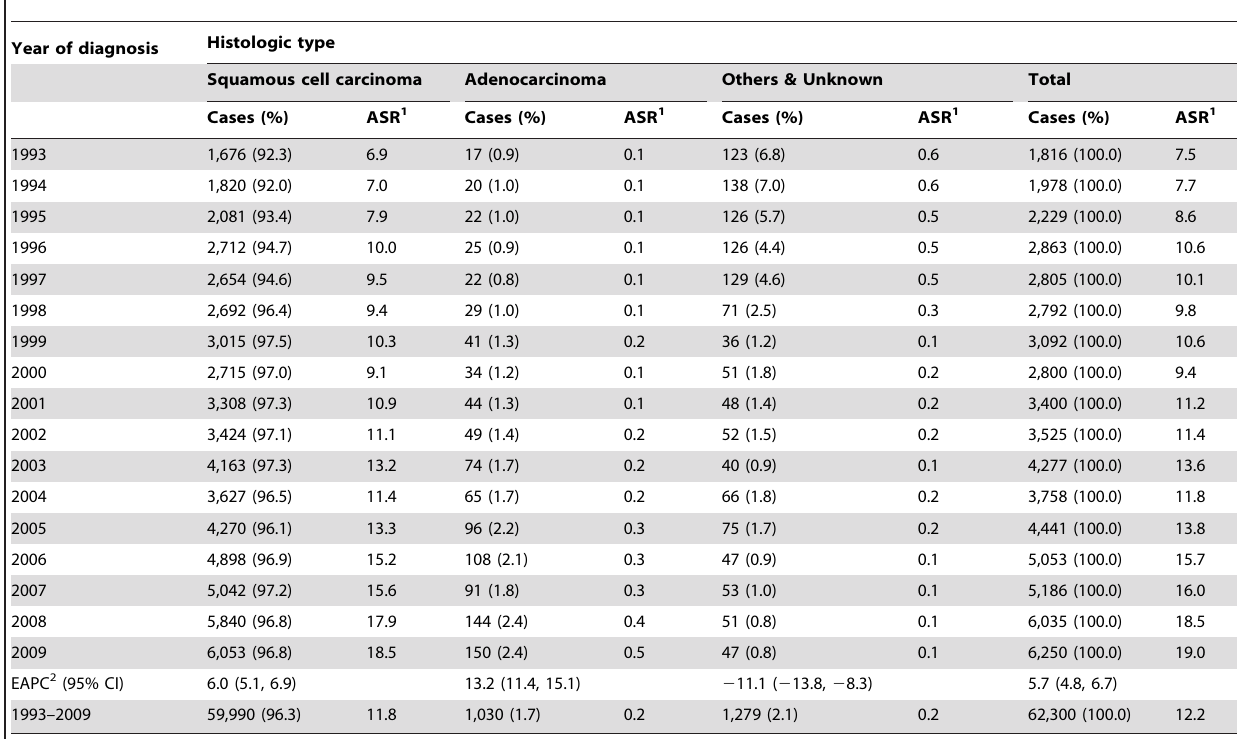
Year of diagnosis